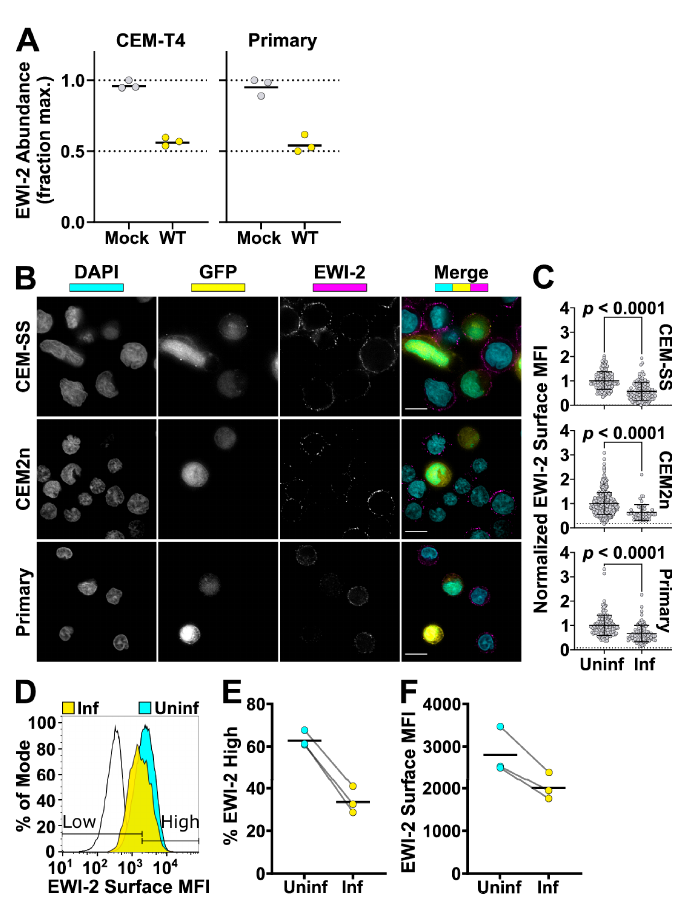
Figure 3. EWI-2 is downregulated from the surface of infected cells. ( A ) Abundance of EWI-2 in mock-infected (grey) versus WT HIV-infected (yellow) CEM-T4 T cells or primary human CD4 + T cells. Experiments were conducted in triplicate and whole cell lysates subjected to Tandem Mass Tag (TMT)-based quantitative proteomics 48 h after infection (reanalysis of data from [50] and [51]). Seven (CEM-T4 T cells) or six (primary human CD4 + T cells) unique peptides were used for EWI-2 quantitation. Mean relative abundances (fraction of maximum TMT reporter ion intensity) shown. ( B ) Cells were infected with NL-sfGI and surface-labeled for EWI-2, fixed, stained with DAPI (shown in cyan) and Alexa Fluor 594-conjugated secondary antibody, and imaged. GFP signal (yellow) was used to identify infected cells, and EWI-2-associated signal is shown pseudocolored in magenta. Representative cells are shown. Scale bars = 10 µ m. ( C ) Cells were prepared as in ( B ) and EWI-2 levels at the plasma membrane in infected (Inf) and uninfected (Uninf) cells were measured by manually selecting the plasma membrane at the midline of each cell and quantifying the mean EWI-2-associated fluorescence intensity. Fluorescence intensity of each cell was normalized to the average intensity value of uninfected cells within the same imaging set. Data shown are pooled from two to three biological replicates, each consisting of two technical replicates. Only non-contact sites were quantified. Error bars = SD. p -values are the result of a two-tailed non-parametric Mann-Whitney U test. (C-E) CEM2n cells were infected with NL-sfGI and surface-labeled for EWI-2, fixed, and stained with Alexa Fluor 647-conjugated secondary antibody, and analyzed by flow cytometry. ( D ) Representative histogram normalized to mode of the EWI-2 signal intensity at the cell surface for unstained controls (black outline), infected cells (yellow), and uninfected cells (cyan). The gates defining EWI-2 high and EWI-2 low cells are shown. ( E ) Data represent the percentage of uninfected and infected cells that fell into the EWI-2 high gate shown in ( d ) from 3 independent biological replicates, averaged across two technical replicates within each. ( F ) EWI-2 surface expression was measured by mean fluorescence intensity (MFI) of EWI-2-associated signal. In both panels, lines connect paired data points, i.e., infected cells and uninfected cells (within an infected tube) from the same biological